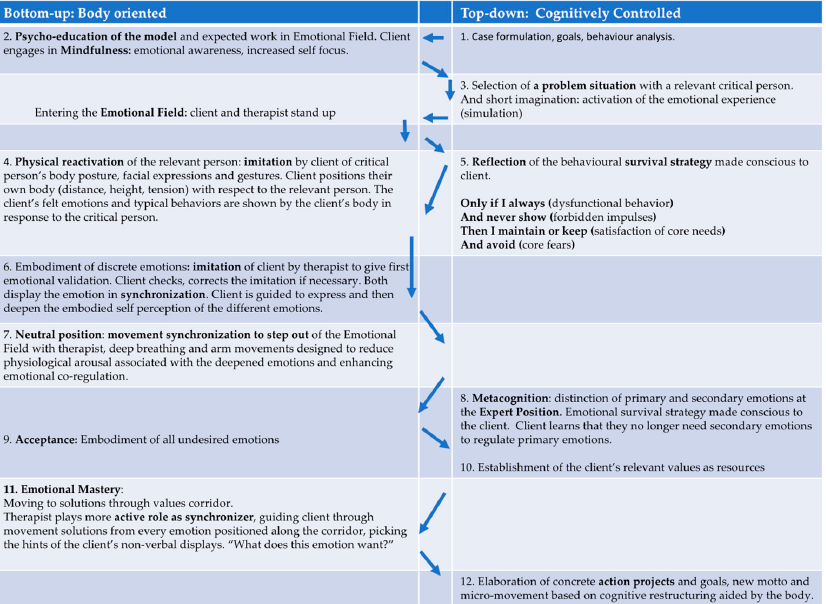
Figure 1. Overview of the switch between top-down and bottom-up orientation.